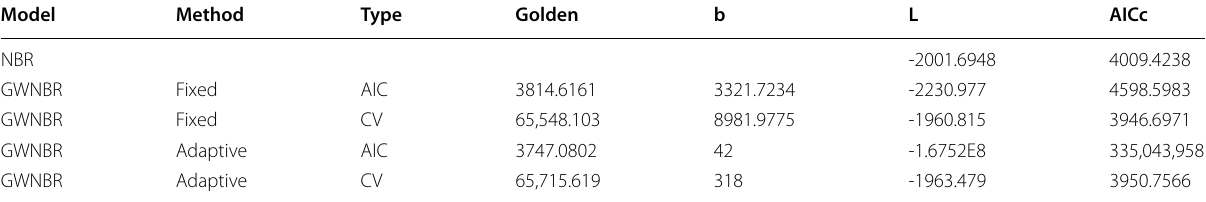
Table 5 Optimum bandwidth